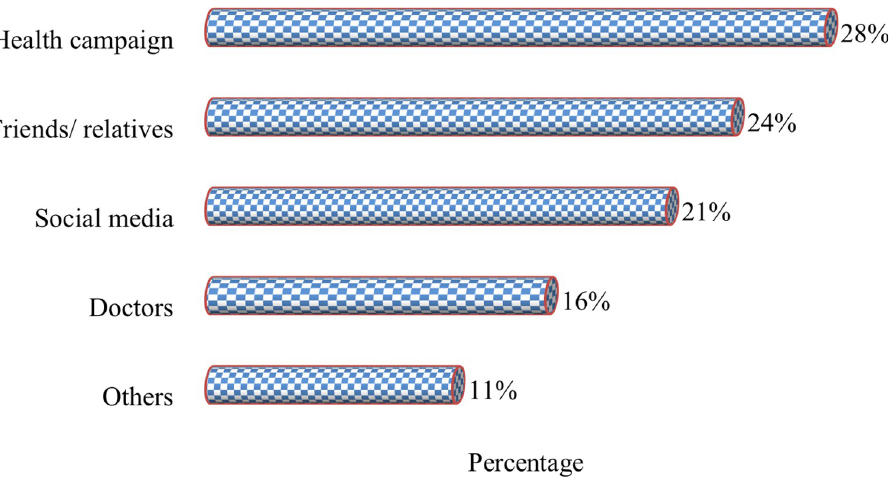
Fig 1. Source of information about breast